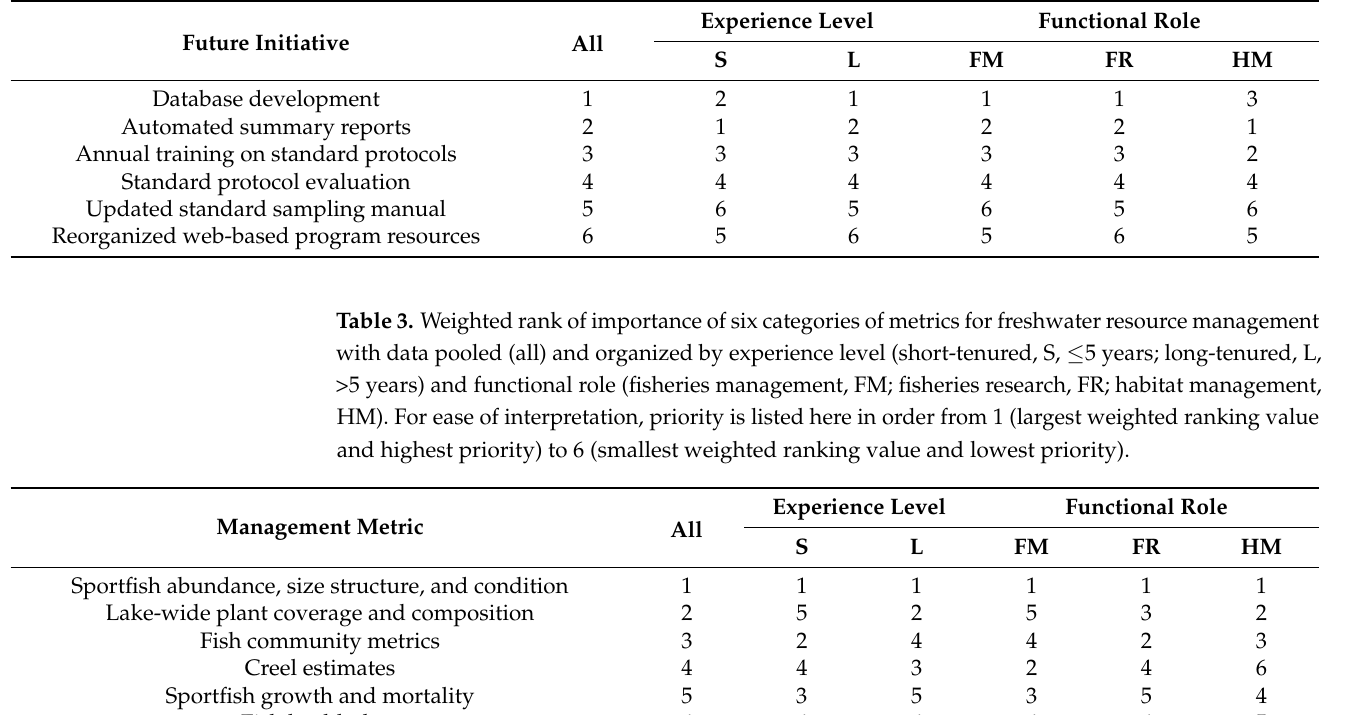
Table 2. Weighted rank of importance of six future initiatives with data pooled (all) and organized by experience level (short-tenured, S, ≤ 5 years; long-tenured, L, >5 years) and functional role (fisheries management, FM; fisheries research, FR; habitat management, HM). For ease of interpretation, priority is listed here in order from 1 (largest weighted ranking value and highest priority) to 6 (smallest weighted ranking value and lowest priority).